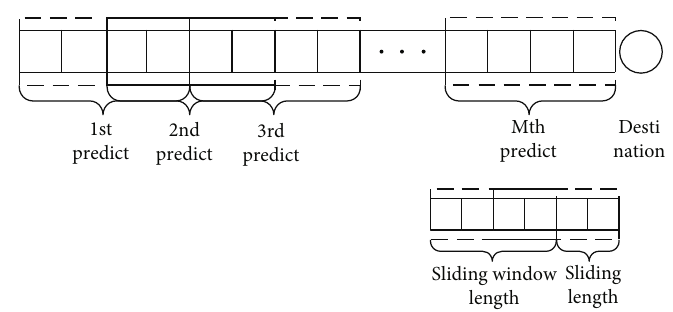
Figure 2: 1-dimensional sliding window structure.